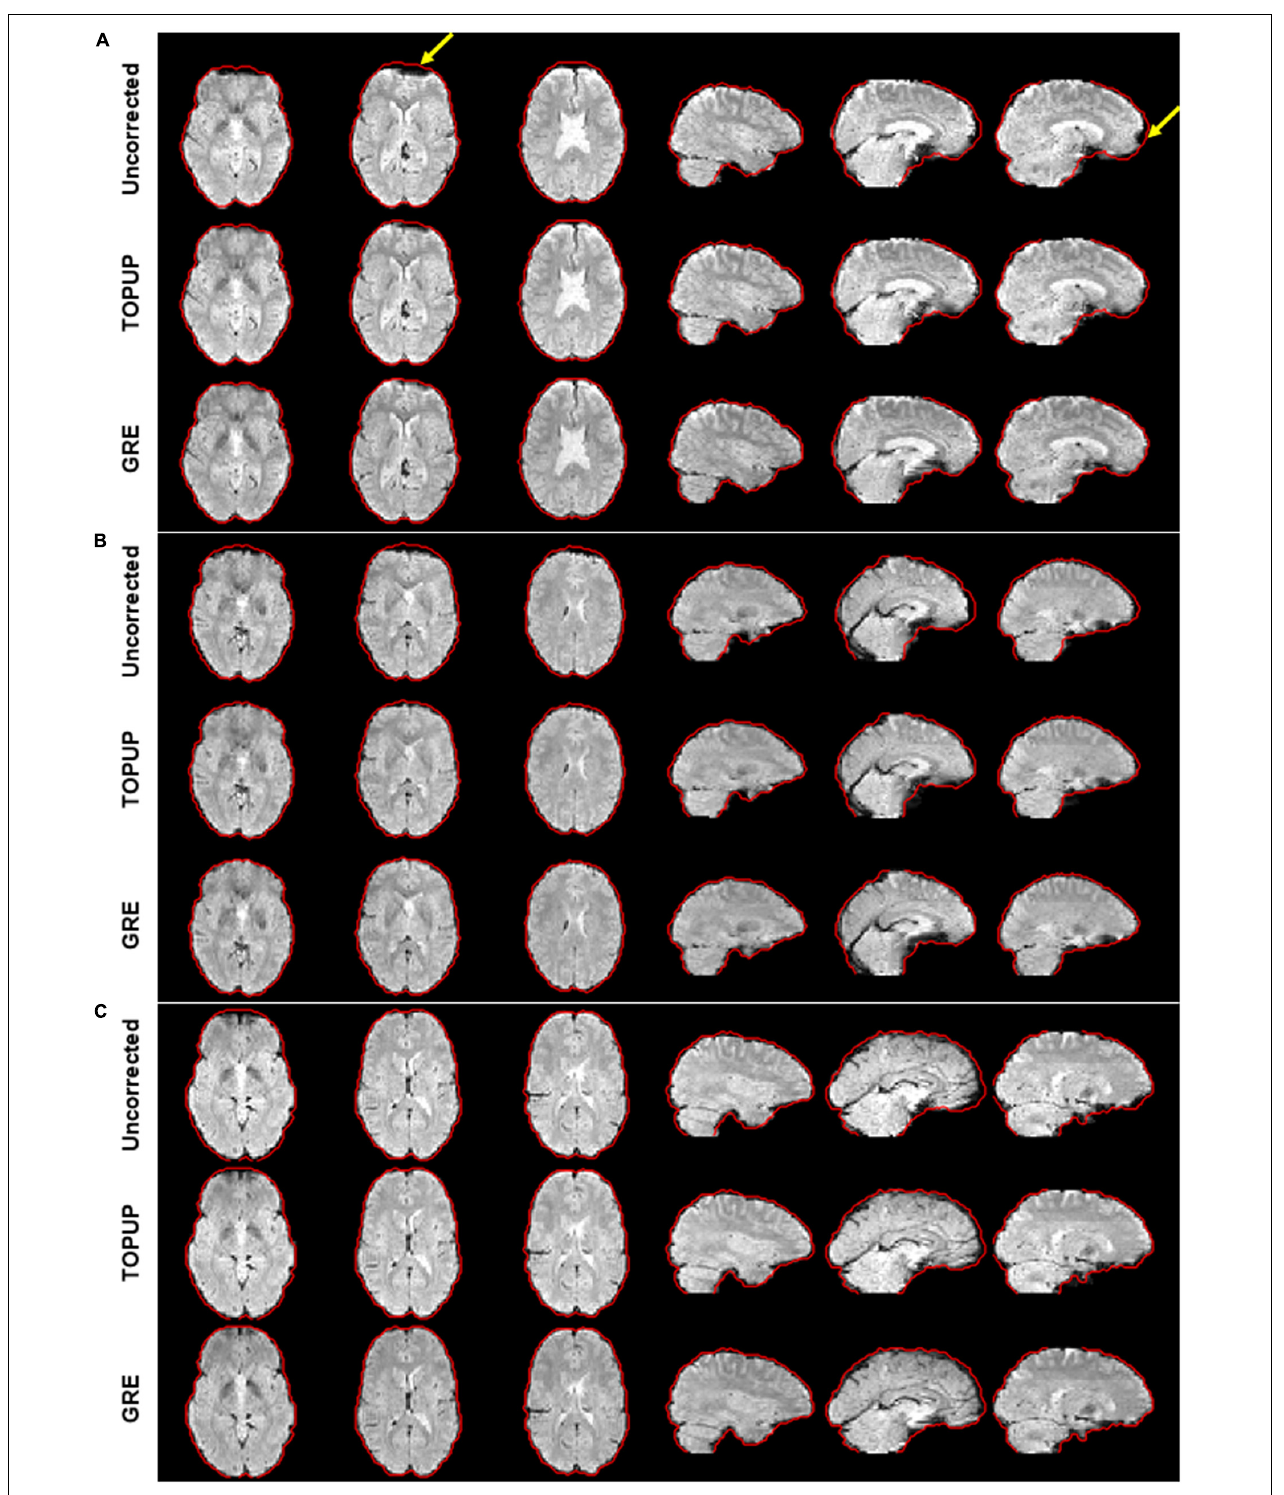
FIGURE 2 | Illustration of the geometric distortions associated with the susceptibility artifact in the fMRI data from three representative participants during the first run of the biological motion perception task. For the first two participants (A,B) , distortions highlighted by the yellow arrows can be observed, mostly representing the compression of voxels in areas of tissue/air boundaries. These were highly attenuated after correction with either TOPUP or GRE correction approaches. Participant (C) does not present clear distortions. The red traces define the contour of the GRE-corrected images, as this approach yielded the best results, and was then considered here as reference for visualization